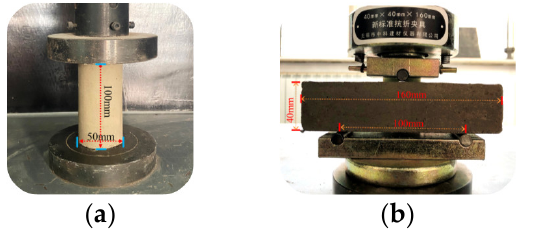
Figure 6. Test loading process. ( a ) Uniaxial compression test process ( b ) Three-point bending test process.